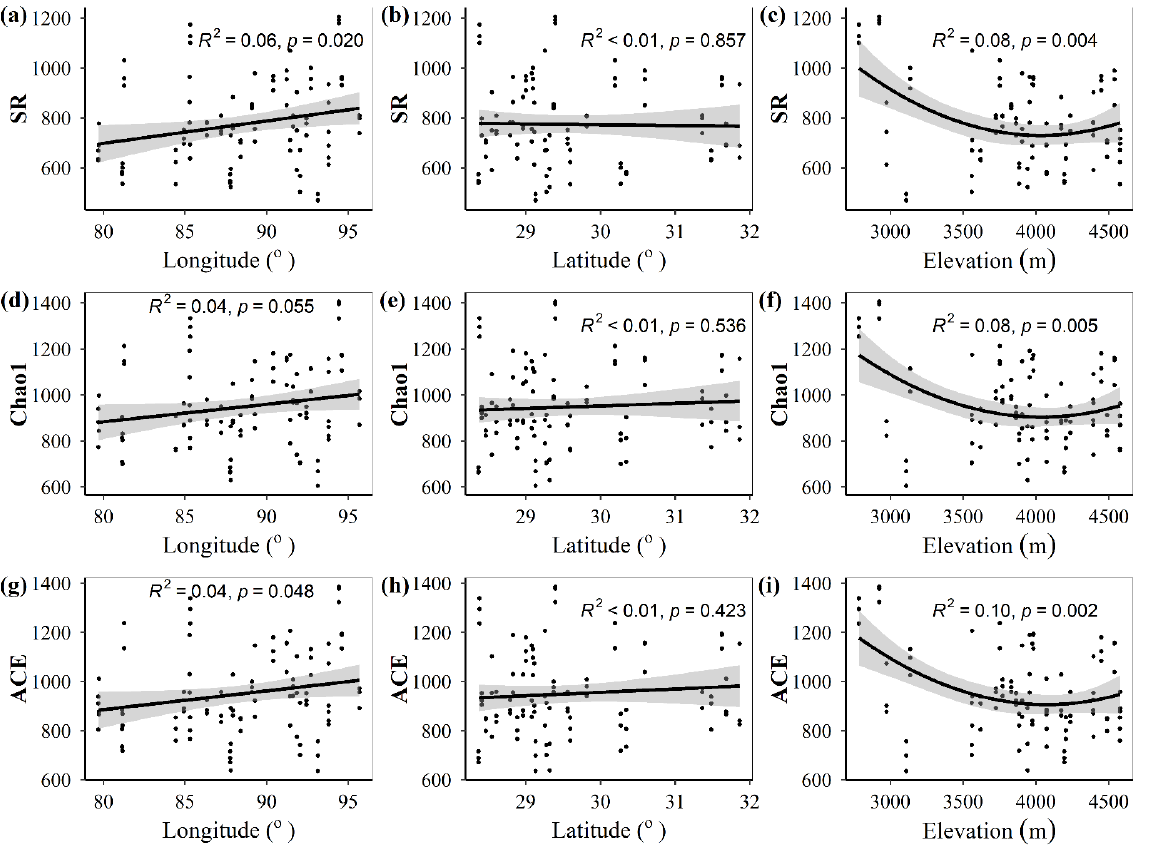
Figure A11. Relationships between species α -diversity and geographic variables (longitude, latitude, and elevation) at 0–10 cm depth. ( a – c ) species richness (SR), ( d – f ) Chao1, ( g – i ) ACE, ( j – l ) Shannon, and ( m – o ) Simpson.